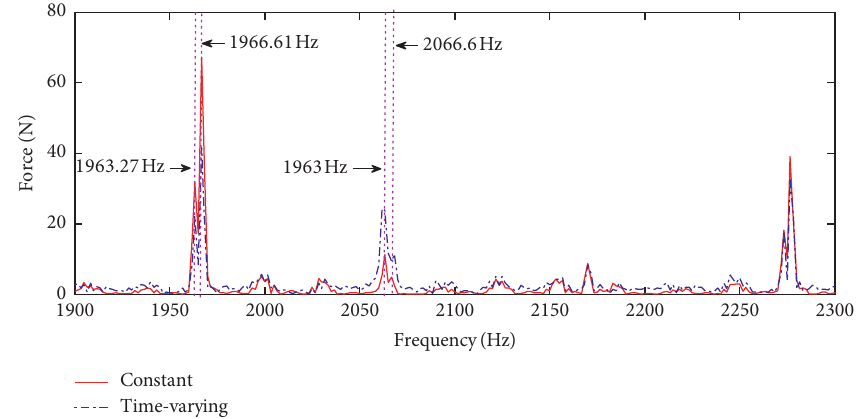
Figure 25: Spectral of meshing force for s- p